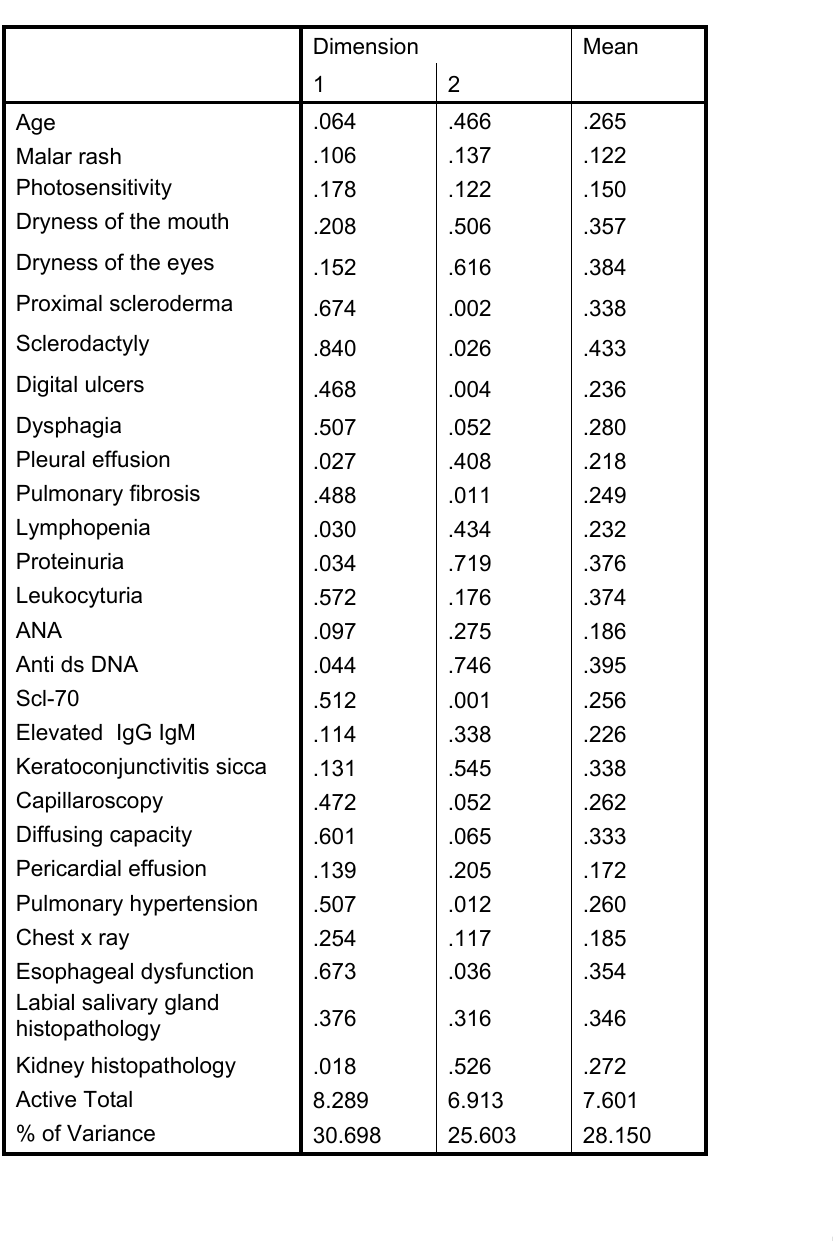
Table 3 – Discrimination measures of the variables, 2D solution Таблица 3 – Дискриминативные значения переменных , 2 Д решение Табела 3 – Дискриминационе мере променљивих , 2 Д